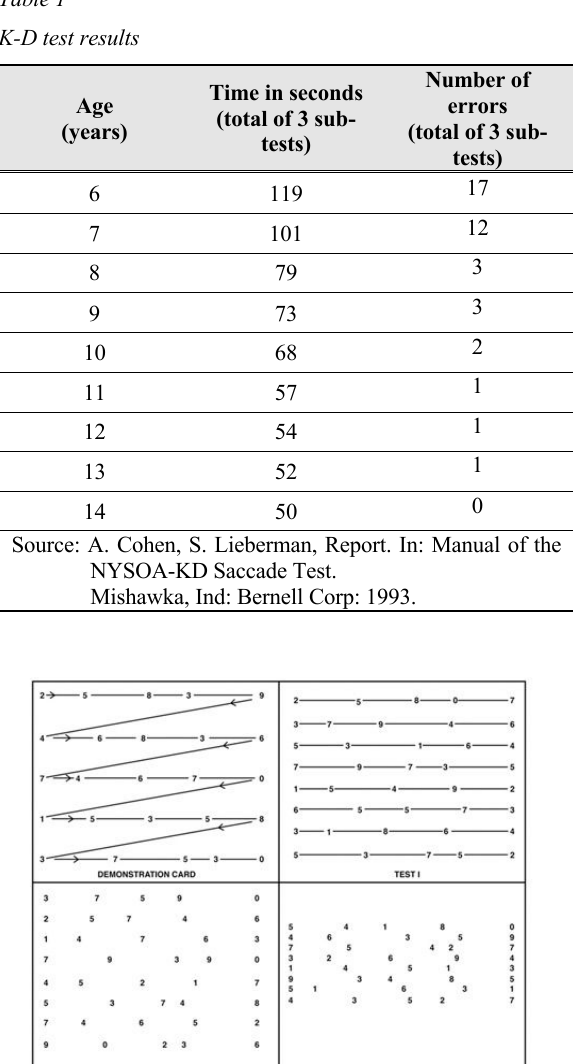
Figure 1. K-D test chart